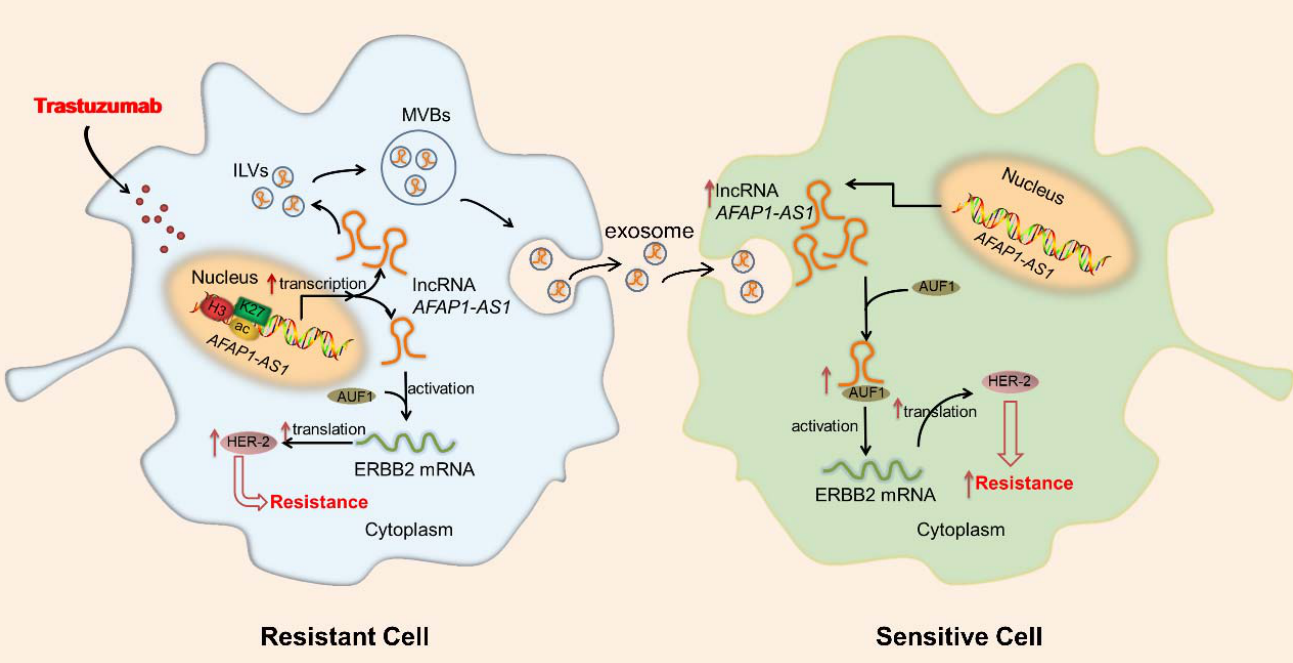
Figure 7. Scheme of the proposed mechanism related to lncRNA AFAP1-AS1 in trastuzumab-resistant breast cells. Trastuzumab treatment increases AFAP1-AS1 expression, which is upregulated by H3K27ac modification at the promoter region. AFAP1-AS1 induces trastuzumab resistance by binding to the AUF1 protein and promoting the translation of ERBB2 mRNA. In addition, extracellular AFAP1- AS1 from trastuzumab-resistant cells was packaged into exosomes and disseminated trastuzumab resistance in trastuzumab-sensitive cells [143]. ILVs, intraluminal vesicles; MVBs, multivesicular bodies; H3K27ac, histone H3 at lysine 27 acetylation; AFAP1-AS1 , actin filament associated protein 1 antisense RNA 1; AUF1, AU-binding factor 1.